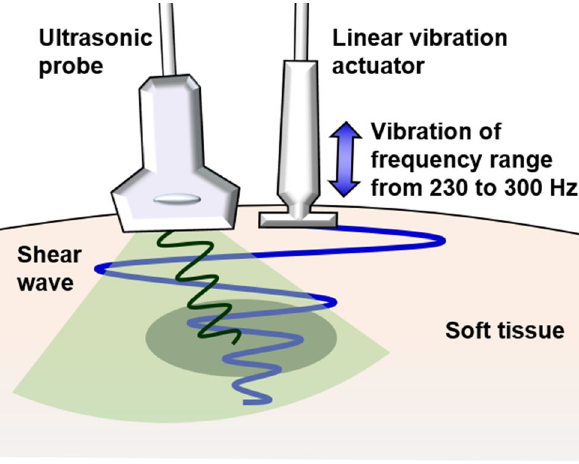
Figure 4. Schematic of color Doppler shear wave